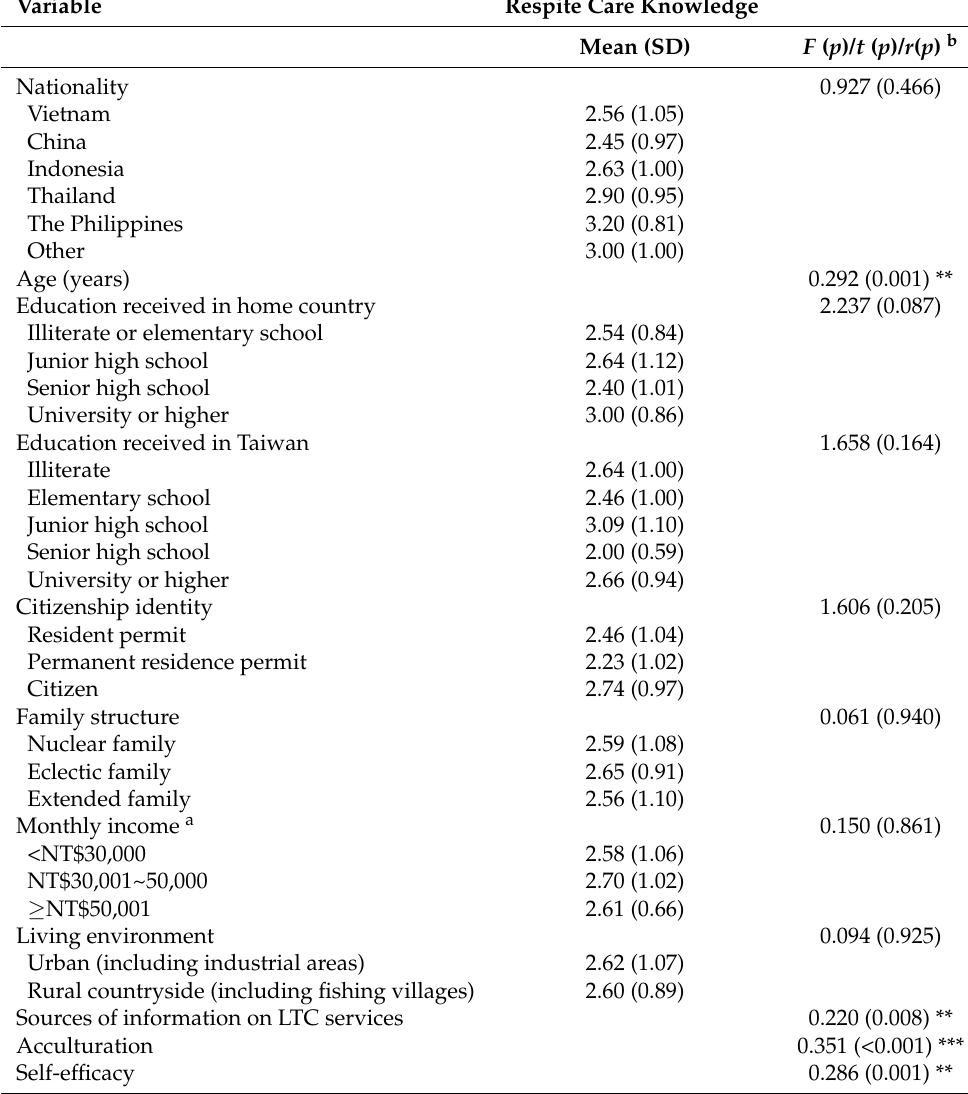
Table 2. Associations between demographics and respite care knowledge ( n =